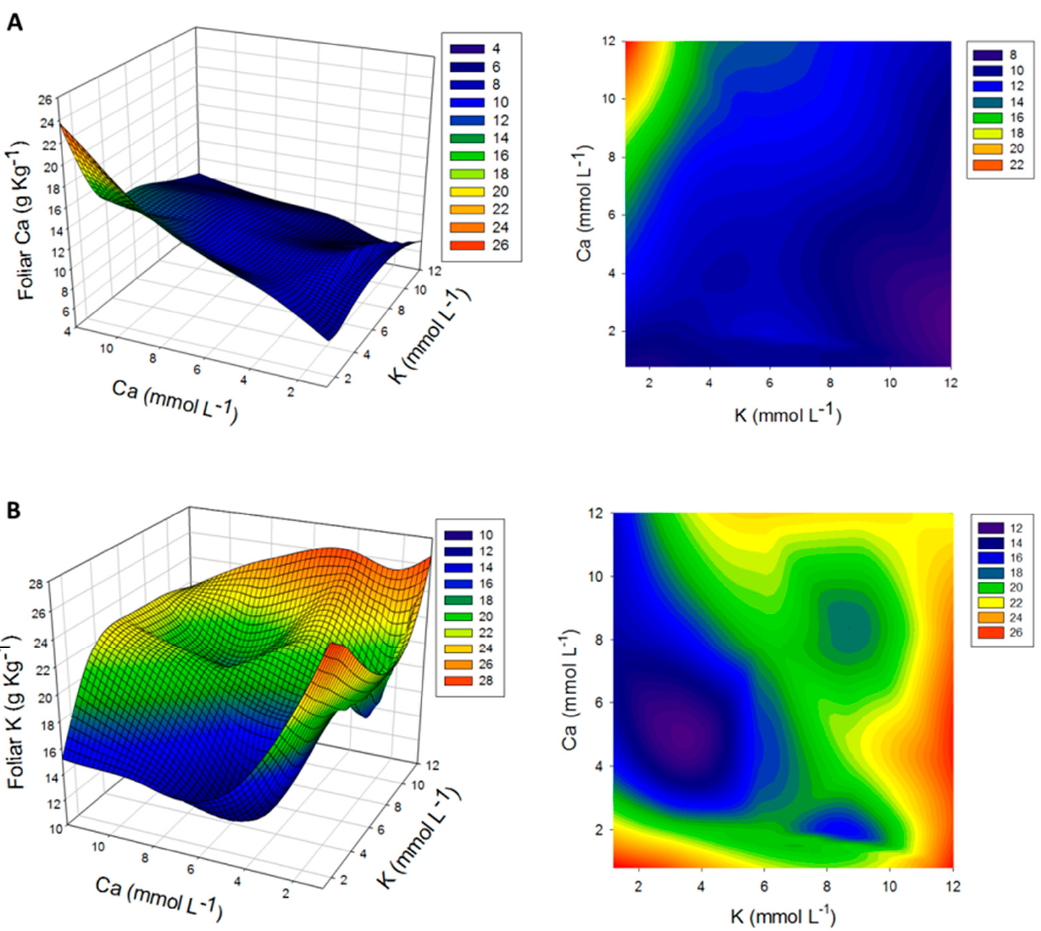
Figure 6. Leaf contents of calcium ( A ) and potassium ( B ) (g kg − 1 ) as a function of the supply of different doses of Ca and K (mmol L − 1 ) in the nutrient solution.